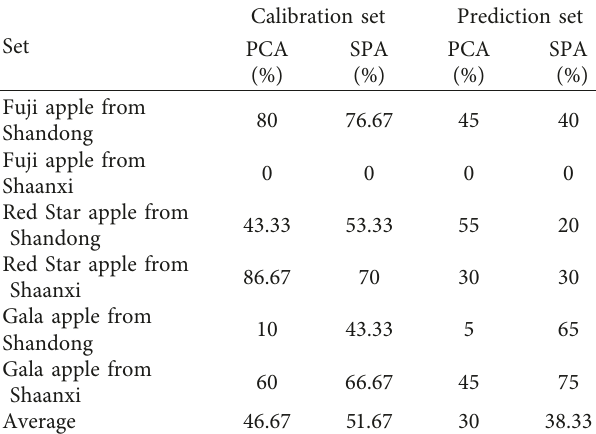
Table 4: Classification accuracies of BPNN models.